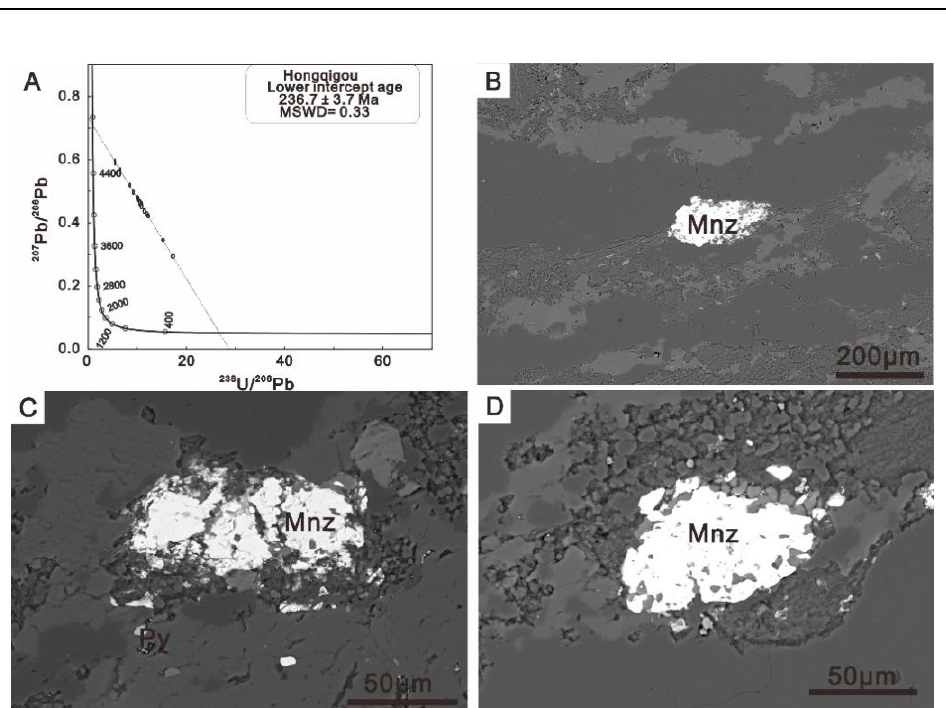
Figure 7. ( A ) The U–Pb Tera–Wasserburg Concordia diagram of monazite in the Hongqigou deposit; ( B – D ) BSE images of typical monazite grains in stage 2 ores of the Hongqigou deposit. Abbreviations: Mnz = monazite.